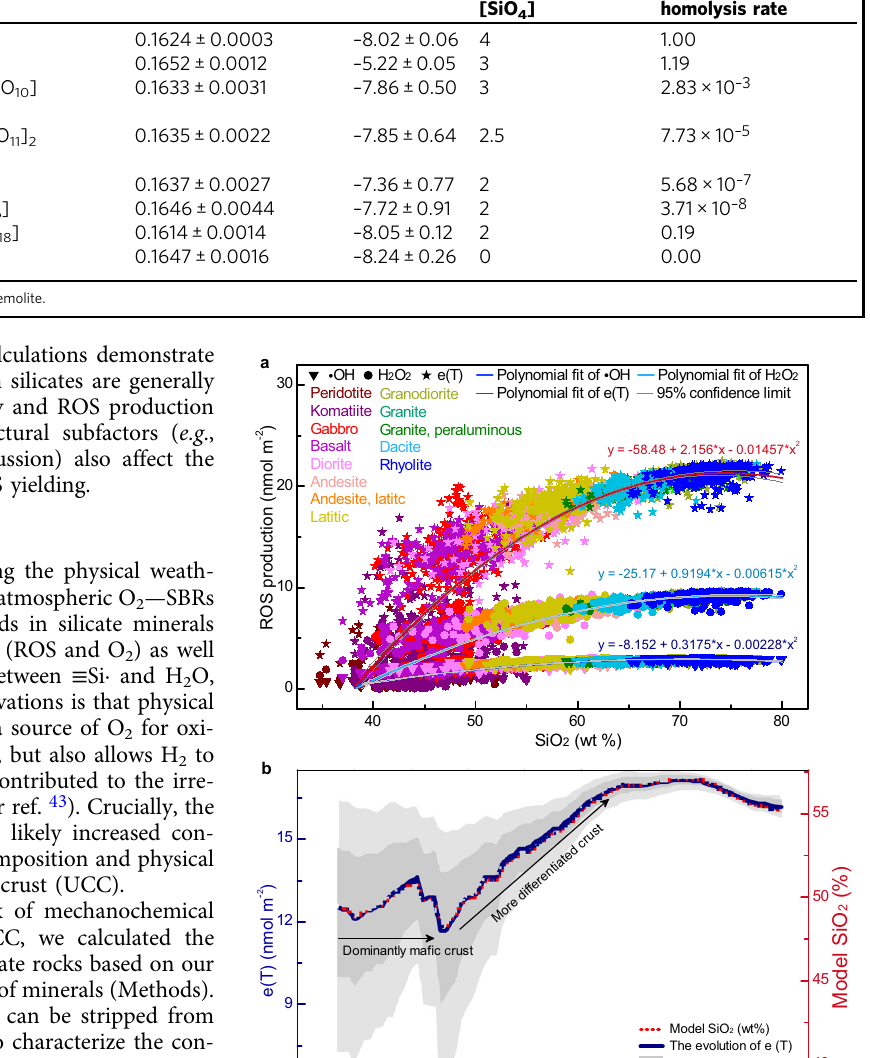
Table 1 The calculated structure-controlled homolysis rates of Si – O bonds of some silicates at 298.15 K. Structures Minerals Crystallo-chemical